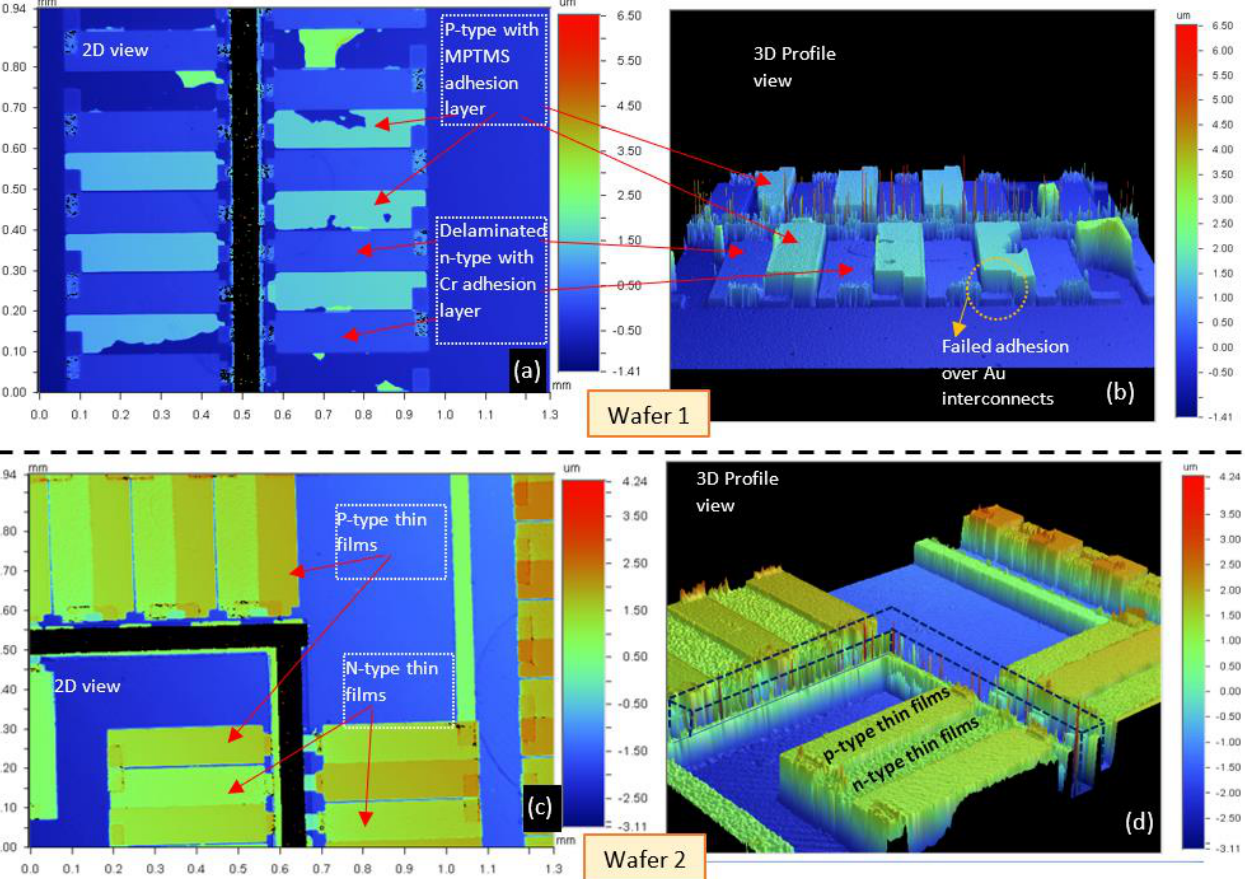
Figure 14. ( a ) 2D view of a section on W1 depicting the failed lift − off of n − type thin films having a Cr adhesion layer and the partially failed lift − off of p − type thin films with MPTMS adhesion layer ( b ) 3D profiles created from ( a ) that highlight the lack of adhesion between p − type thin films and the interconnects. In the n − type areas, only the Cr adhesion layer is left. ( c ) 2D view of a section on W2 displaying the thermoelectric thin films showing the p − type and n − type thin films, metal contacts, and the bonding ring. ( d ) 3D view created from the optical profilometry data measured in ( a ). The dashed lines are drawn to indicate the bonding ring as the profilometry tool could not focus on the top of the Au bonding ring